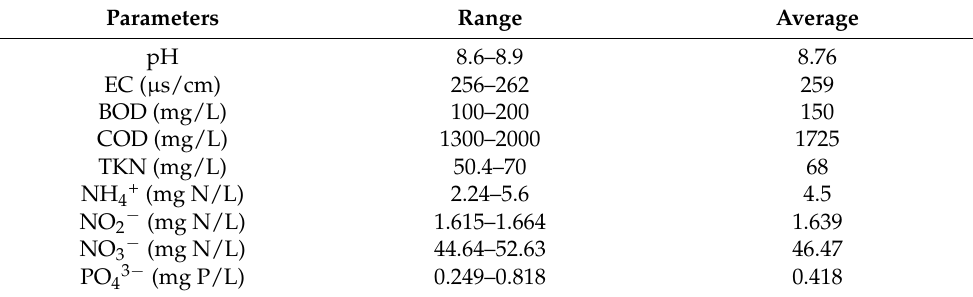
Table 2. Characteristics of